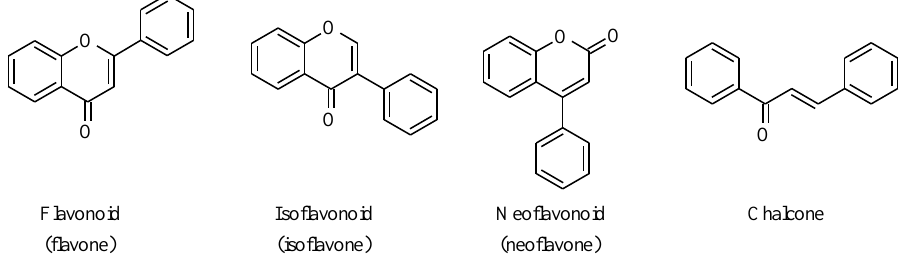
Figure 1. Different classes of